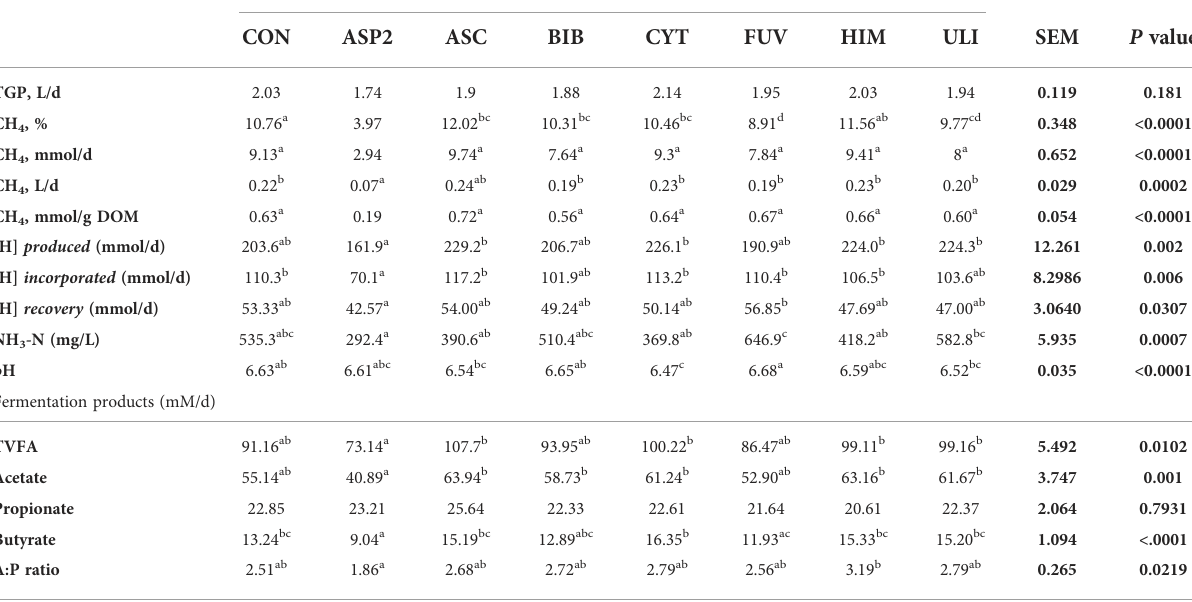
TABLE 6 Effects of seaweed inclusion on gas production parameters and fermentation patterns in the RUSITEC system (Experiment 2).